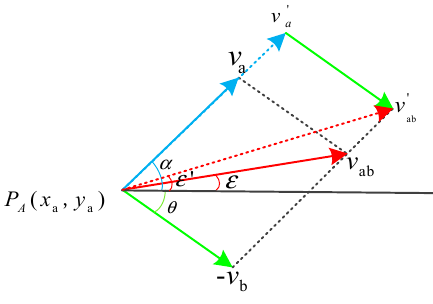
Figure 4. Speed deliverance. The blue dashed line in the figure indicates the velocity of the UAV after changing the numerical size of the velocity v (cid:48) , whose angle with the X axis positive is still α , and the a red dashed line indicates the relative velocity of the two v ab , whose angle with the X